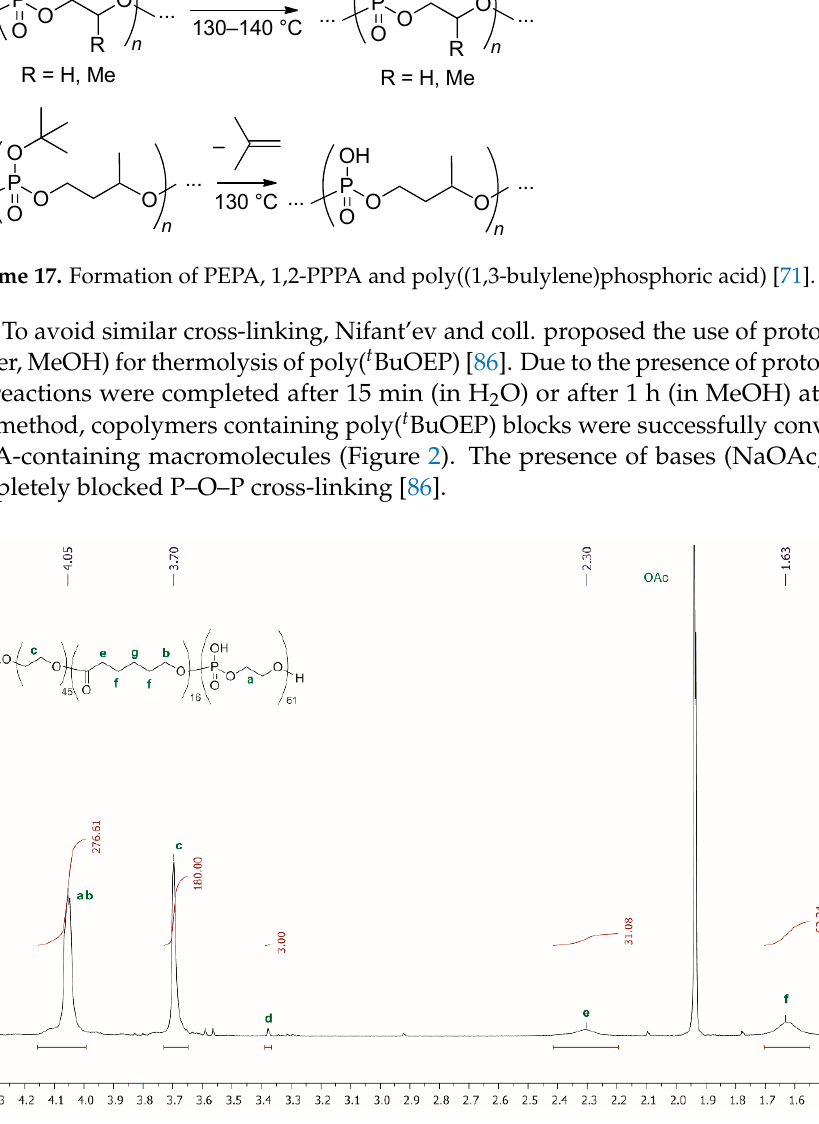
Figure 2. 1 H NMR spectrum (400MHz, D 2 O, 20 °C) of PEPA-containing triblock copolymer obtained after thermolysis of mPEG 2000 - b -( ε CL) 16 - b -( t BuOEP) 61 H in D 2 O at 80 °C in the presence of NaOAc. Reprinted with permission from [86]. Copyright (2018) Elsevier B. V.